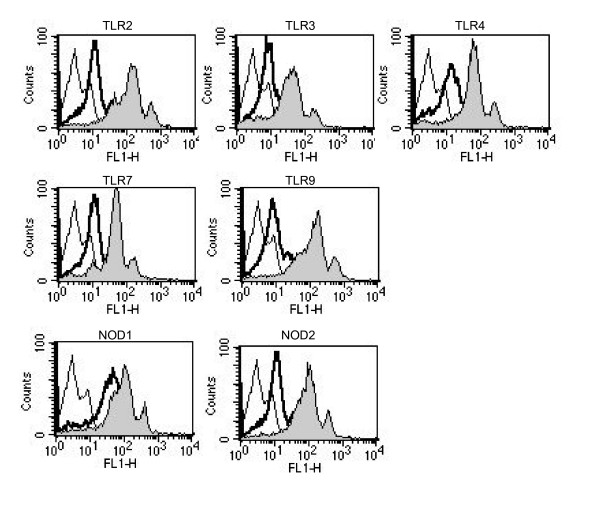
Up-regulation of the expression of TLR2, TLR3, TLR4, TLR7, TLR9, NOD1, and NOD2 in human PBMCs in response to anti-PR3 Abs. PBMCs were stimulated with murine anti-human PR3 Abs (1 μg/ml, filled graphs) or an isotype-matched control IgG (1 μg/ml, bold line). After 6 h of incubation, the expression of cell-surface TLR2 and TLR4 and intracellular TLR3, TLR7, TLR9, NOD1, and NOD2, was assessed by flow cytometry. The thin lined curve is the staining with a control Ab. The results presented are representative of four different experiments.